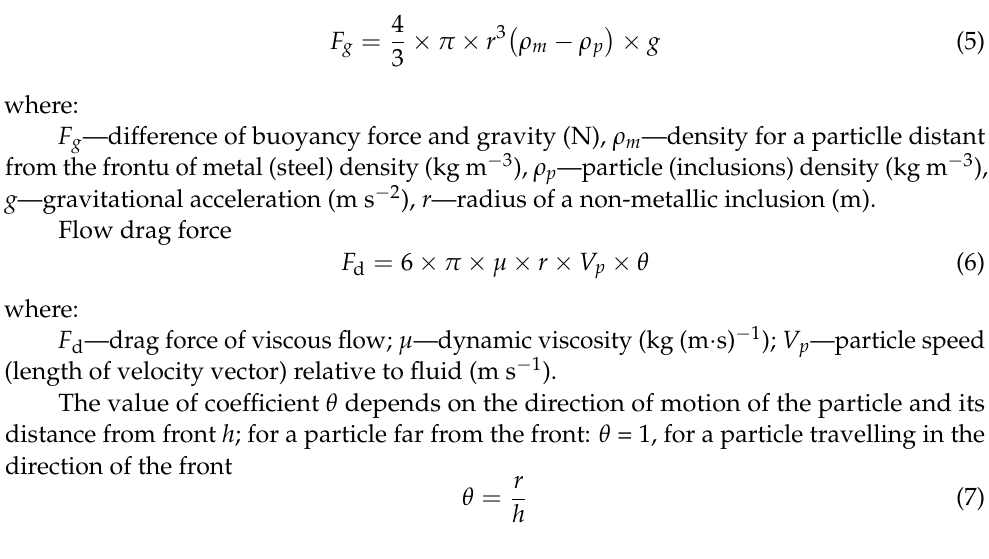
(length of velocity vector) relative to fluid (m s − 1